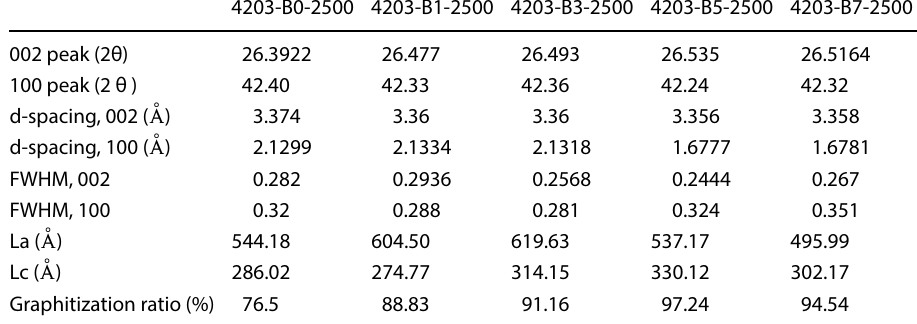
C, b layer structure of 4203-BX-2500 4